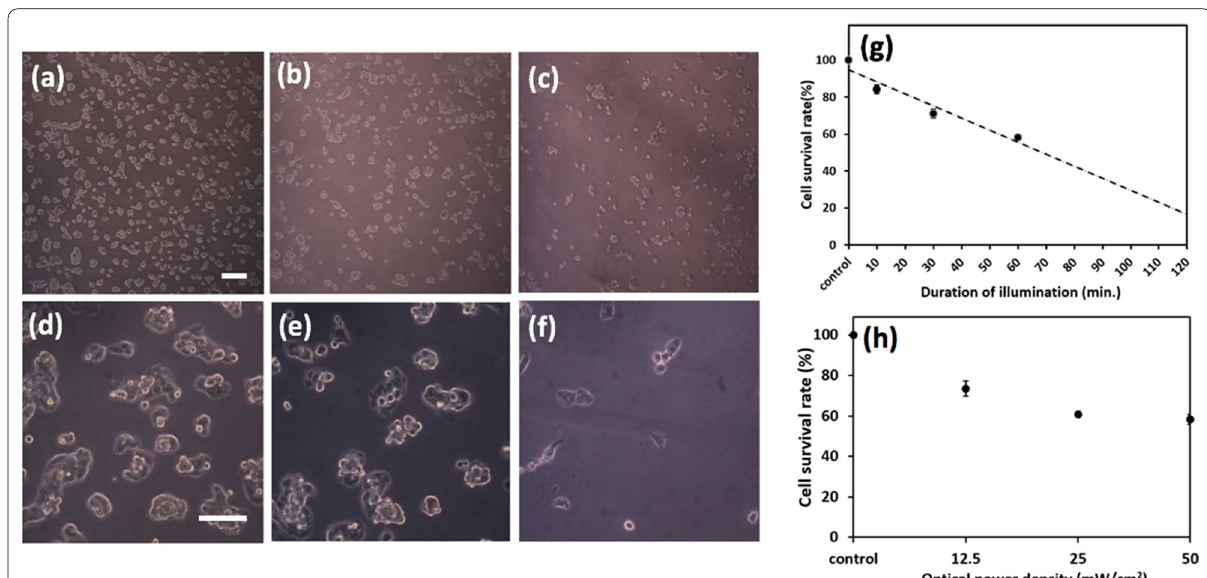
Fig. 5 Photothermal assay. The survival rate of HepG2 cells when dosed with the NP concentration of 1.5 mg/ml alongside NIR irradiation. The respective scale bars on the a – c top and d – f bottom rows of BF optical images are 200 μm and 100 μm. The standard deviation of three experimental trials ( N 3) for each data point is indicated =